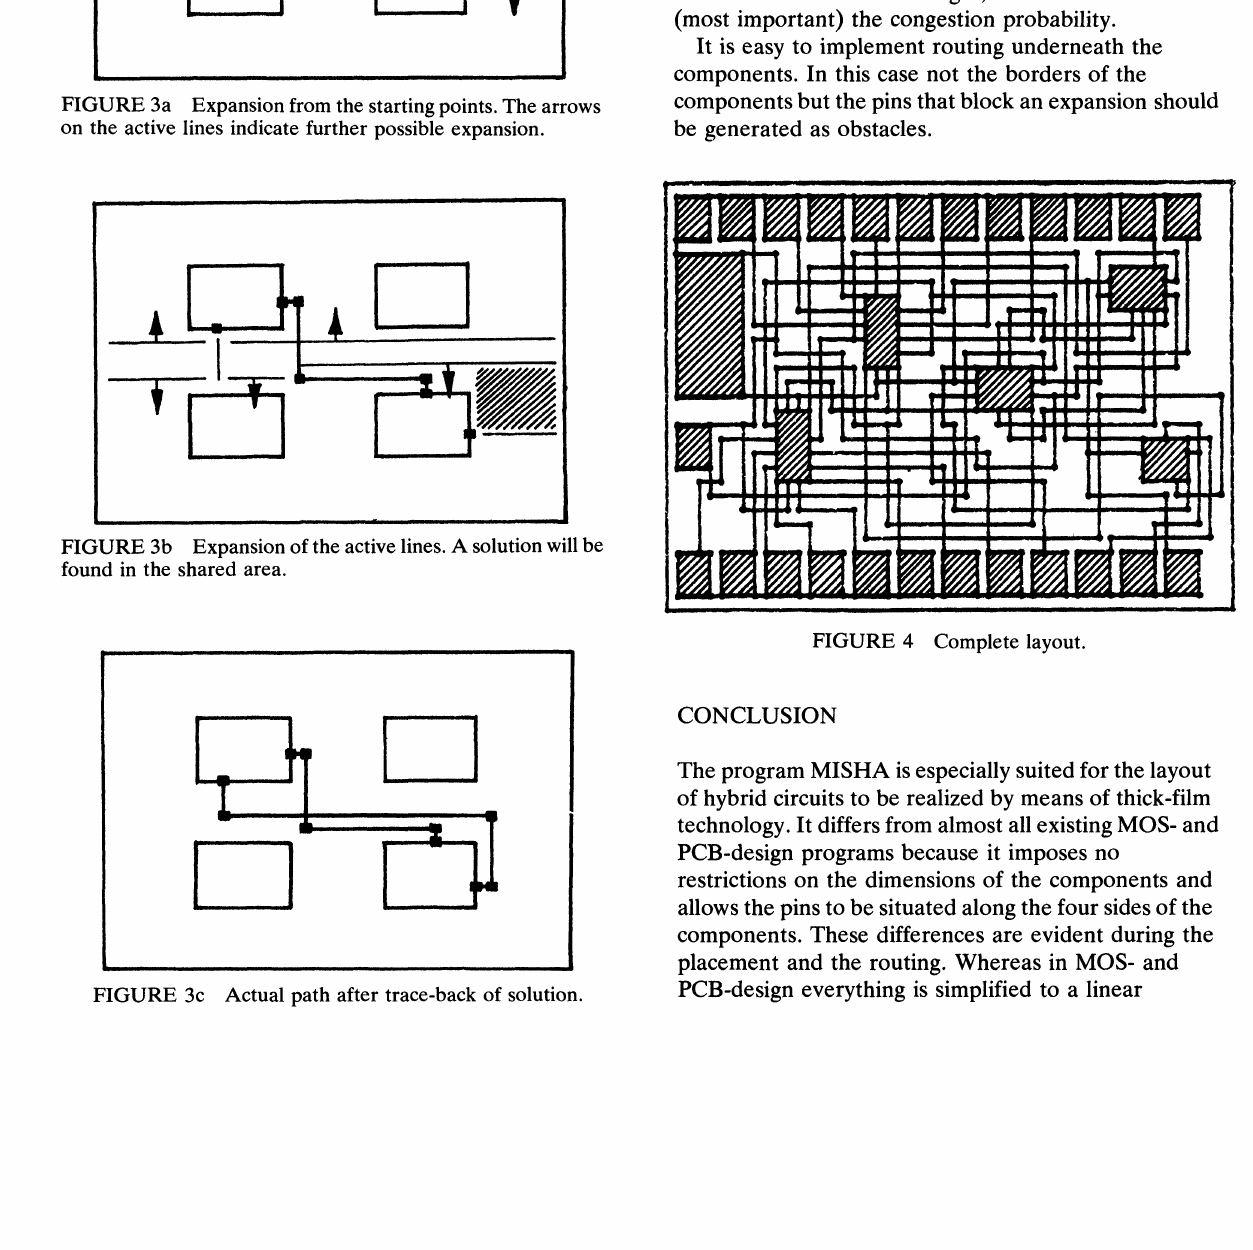
FIGURE 3a Expansion from the starting points. The arrows on the active lines indicate further possible expansion.